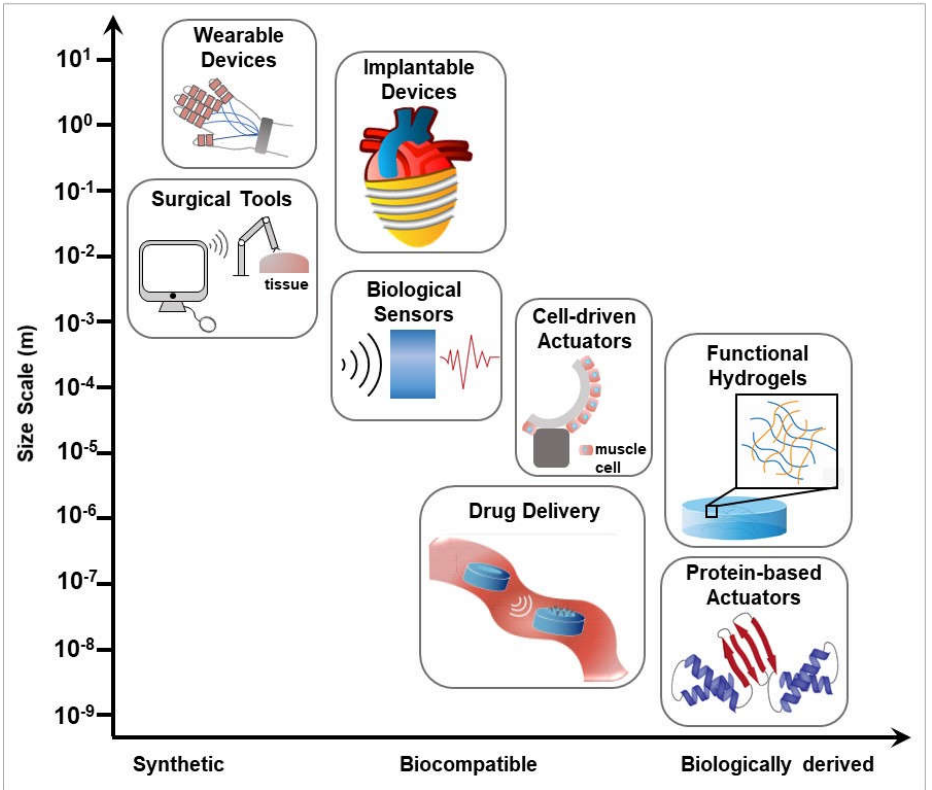
Figure 4. Summary of materials and techniques used in the development of soft robots and medical devices. Techniques are organized by size scale ( y -axis) and material chemistry ( x -axis) from synthetically derived to biologically sourced materials.